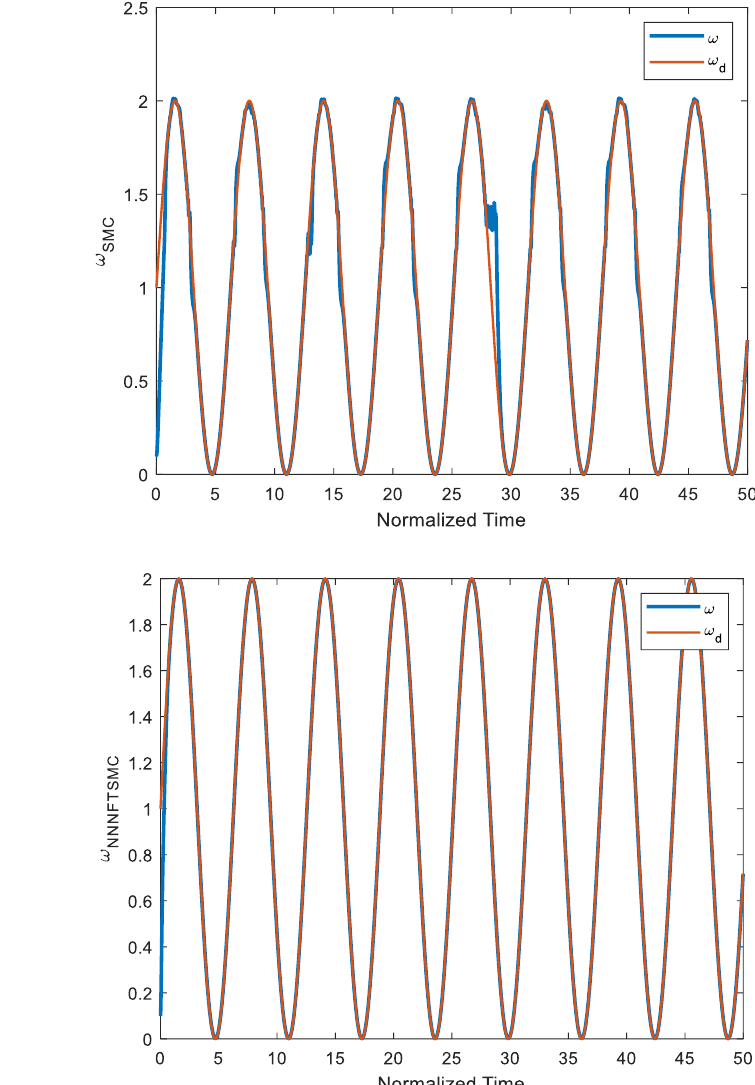
Figure 12. Periodic response of HTGS under random noise ( a ) SMC and ( b ) proposed controller.